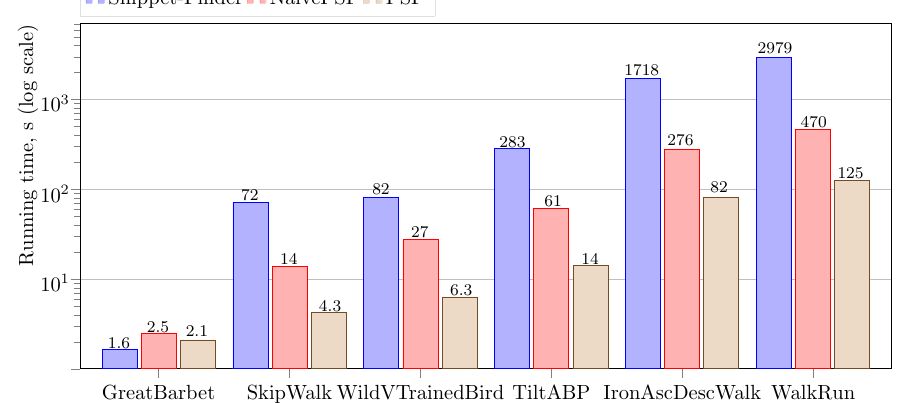
Figure 7. Performance of the PSF